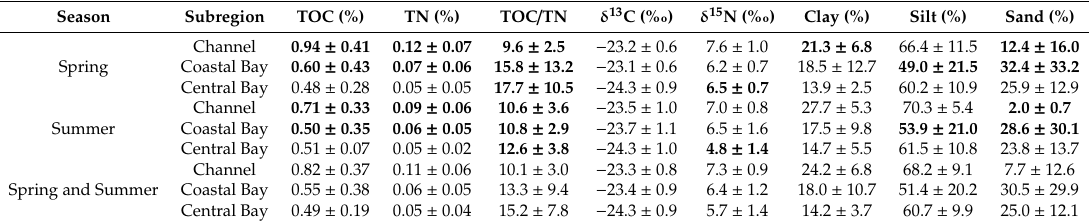
Table 2. Mean values (mean ± SD) of the carbon and nitrogen parameters and grain size compositions for the surface sediments in different subregions of the Zhanjiang Bay. TOC, total organic carbon; TN, total nitrogen; δ 13 C, stable carbon isotope composition; δ 15 N, stable nitrogen isotope composition.